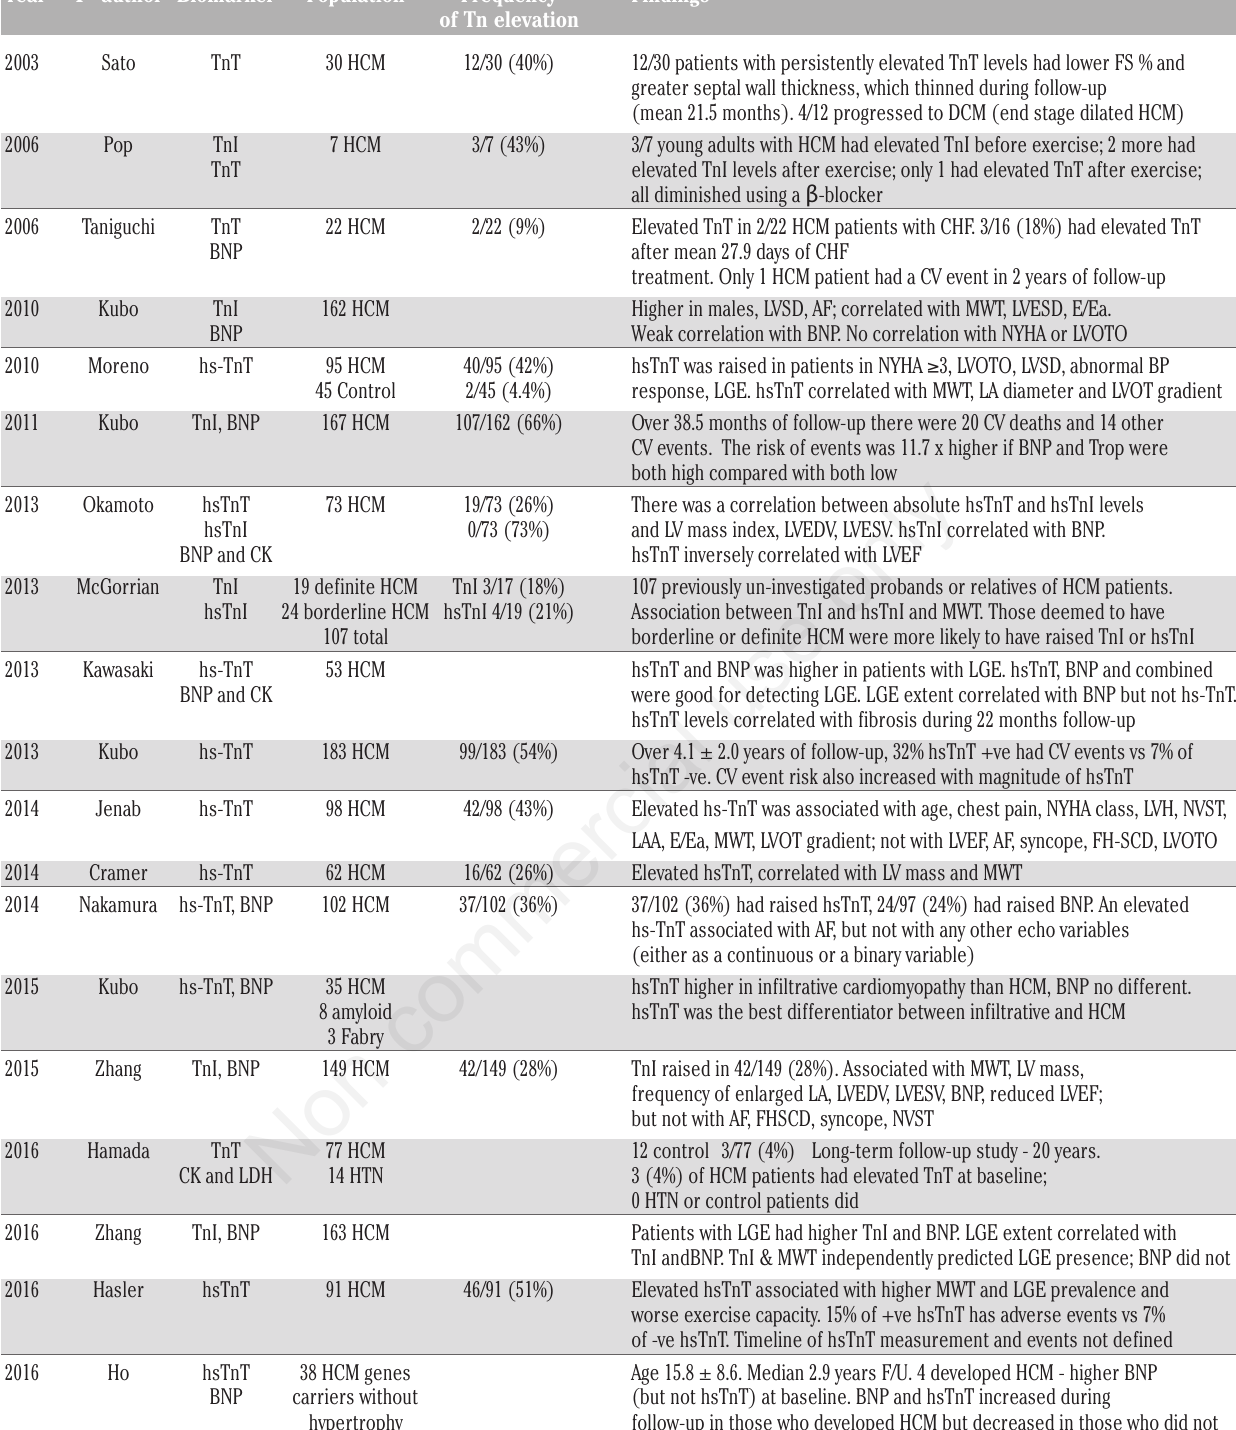
Table 4. Studies evaluating troponin in hypertrophic